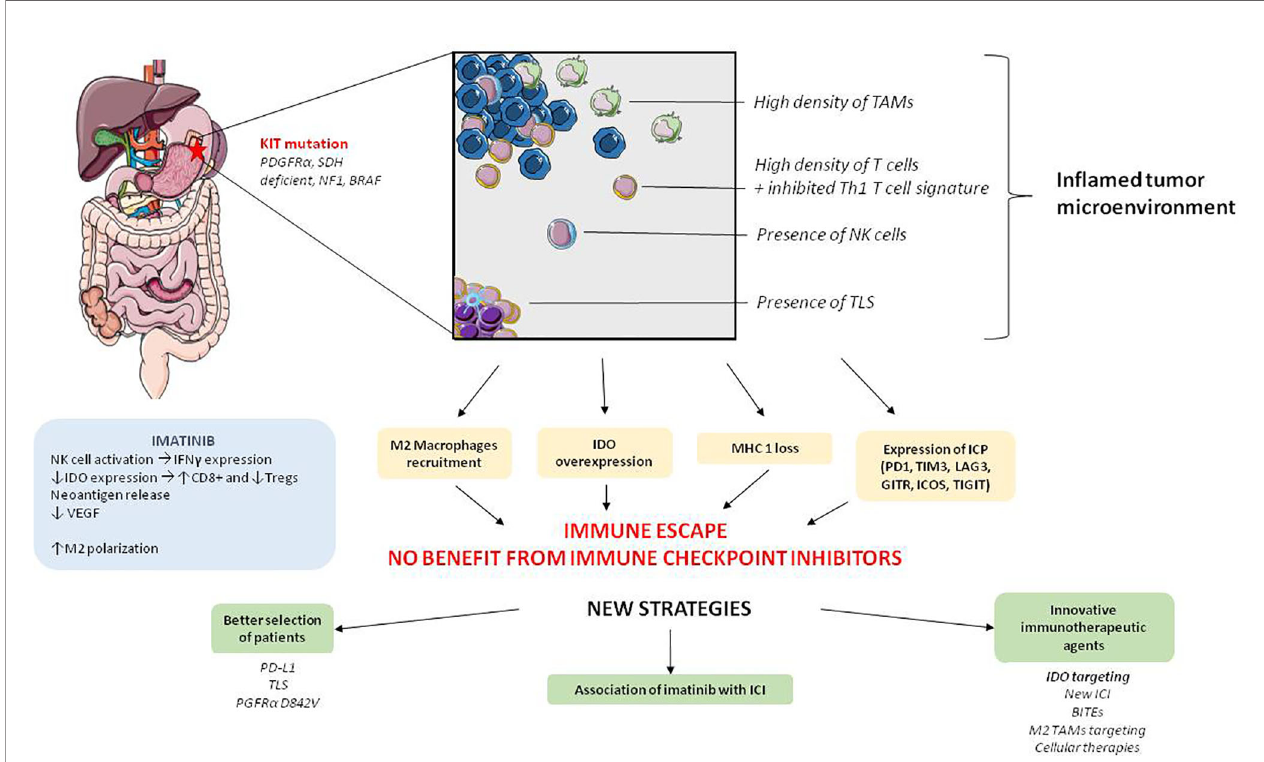
FIGURE 2 | Global characteristics of tumor microenvironment and immunotherapeutic perspectives in GIST. PGFR a : platelet derived growth factor receptor a , SDH, succinate dehydrogenase; NF1, Neuro fi brimin 1; NK cell, Natural killer cells; IDO, Indoleamine 2,3-dioxygenase; MHC, Major histocompatibility complex; ICP, Immune checkpoint protein; VEGF, vascular endothelium growth factor; IFN- g , Interferon- g ; TLS, Tertiary lymphoid structure; PD-1, programmed cell death 1; TIM- 3, T-cell immunoglobulin and mucin containing protein-3; LAG-3, Lymphocyte-Activation Gene 3; GITR, Glucocorticoid-Induced TNFR-Related protein; ICOS, Inducible T-cell costimulatory; TIGIT, T cell immunoreceptor with Ig and ITIM domains); BITEs, Bispe ́ ci fi c T cell Engager antibodies; ICI, immune checkpoint